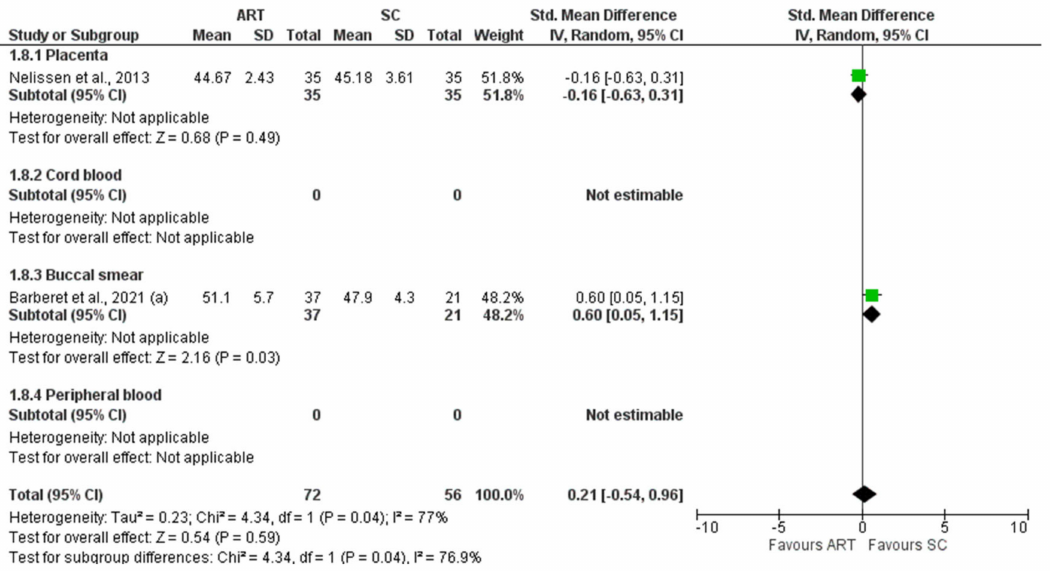
Figure 5. Methylationlevelsof PEG3 [25,52].